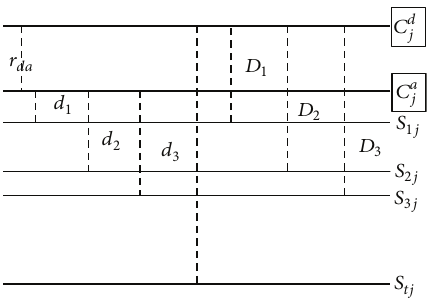
Figure 1: The impact of desirable attribute preference on the